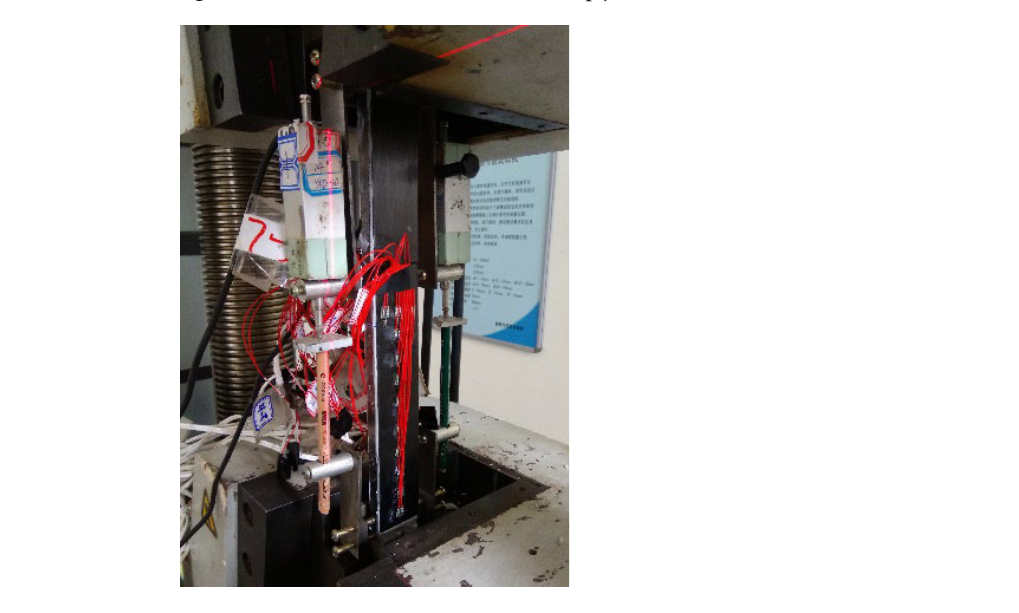
Figure 2. Schematic view of the double-lap joint (mm).